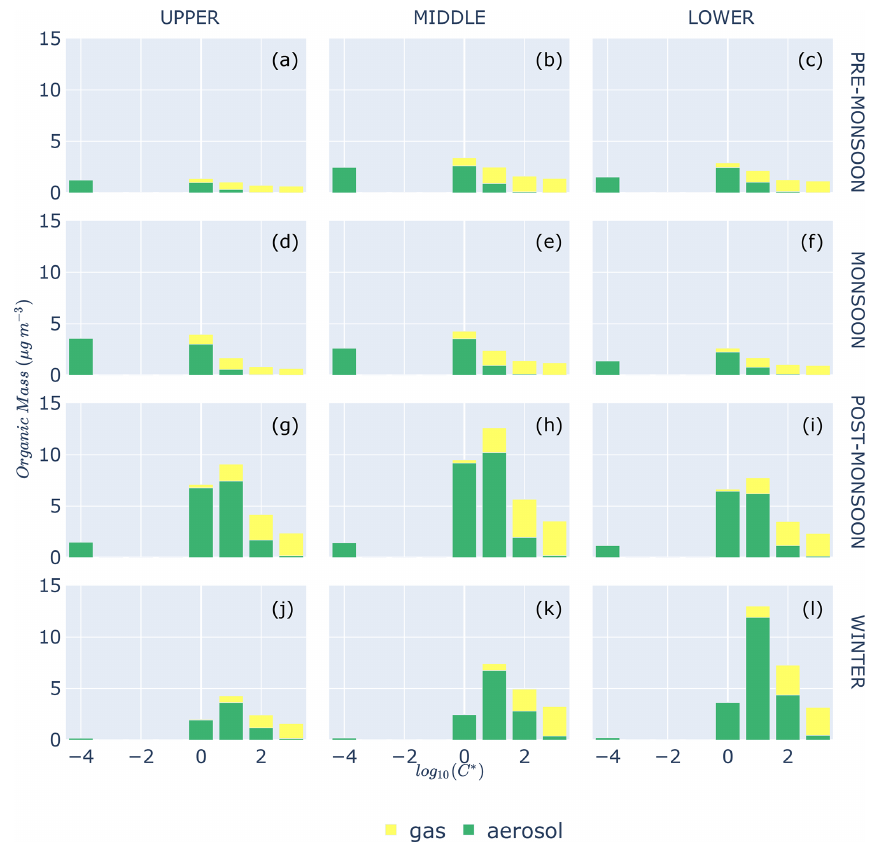
Figure 8. Seasonal mean volatility distribution of SOA over the upper, middle, and lower IGP as calculated within the WRF-Chem 1-D VBS scheme for (a–c) pre-monsoon, (d–f) monsoon, (g–i) post-monsoon, and (j–l) winter